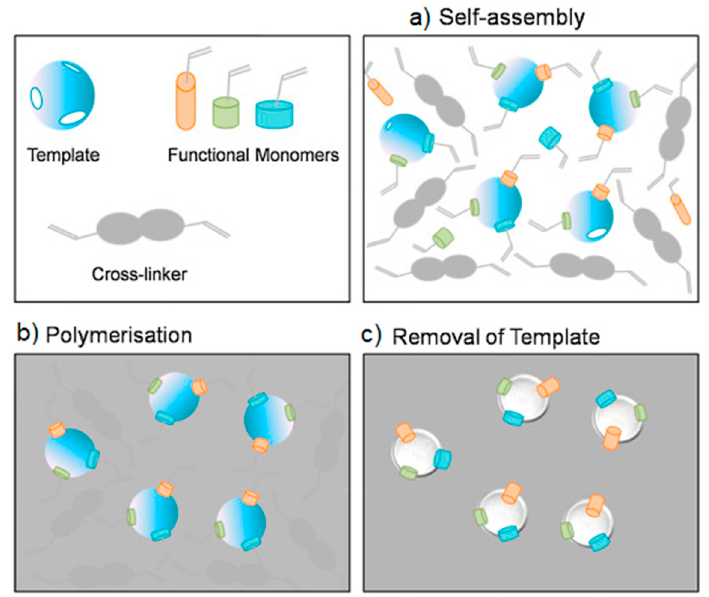
Figure 44. Illustration of the synthesis of molecularly imprinted polymers. Reproduced with permission from Wackerlig et al. [445]. Copyright (2014), 2014 Elsevier B.V.